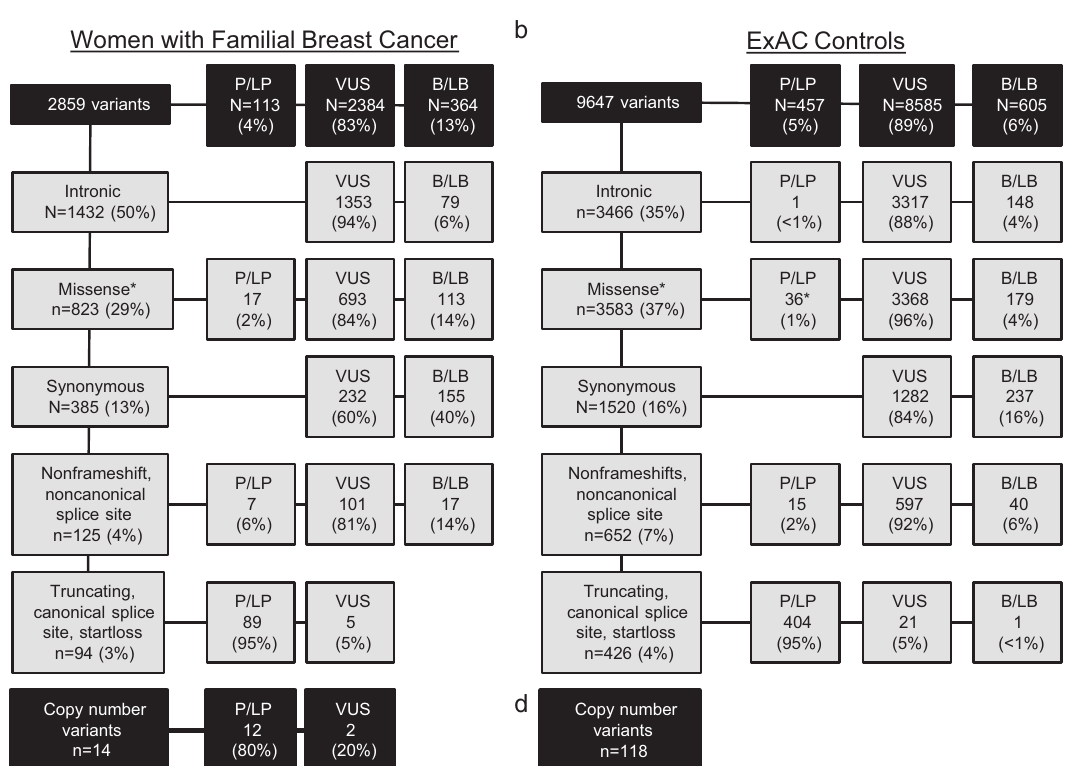
Fig. 1 Variant classes identi fi ed in familial breast cancer women and Exome Aggregation Consortium (ExAC) controls. All single nucleotide and insertion/deletion variants in the 26 studied genes passing sequencing quality fi lters and with alternate allele frequencies (AAF) between 30 and 70% were classi fi ed by the described variant classi fi cation methodology. Variants are divided by general type (noncoding, missense, synonymous, loss of function and other) followed by the breakdown of pathogenic/likely pathogenic (P/LP) variants, variants of uncertain signi fi cance (VUS), and benign/likely benign (B/LB) variants in ( a ) familial breast cancer cases and ( b ) ExAC (The Cancer Genome Atlas excluded) non-Finnish European controls. Asterisks : Includes CHEK2 low-risk alleles p.I157T and p.S428F and MUTYH heterozygous pathogenic mutations in both data sets. The Exome hidden Markov model and COpy number Detection by EXome sequencing algorithms were used to identify copy number variants (CNVs) in the cases ( c ) and analysis of ExAC genome browser data was analyzed to identify CNVs in the controls ( d